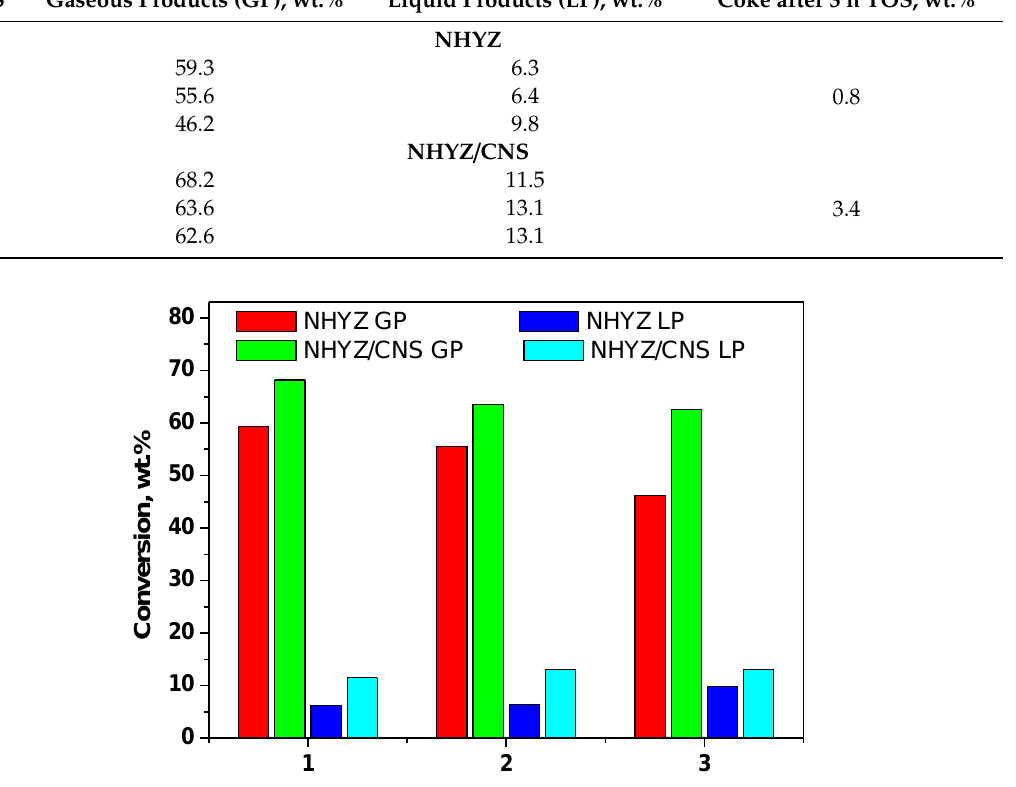
Figure 6. GP and LP for NHYZ and NHYZ/CNS catalysts. Table 3. Selectivity of NHYZ and NHYZ/CNS catalysts.